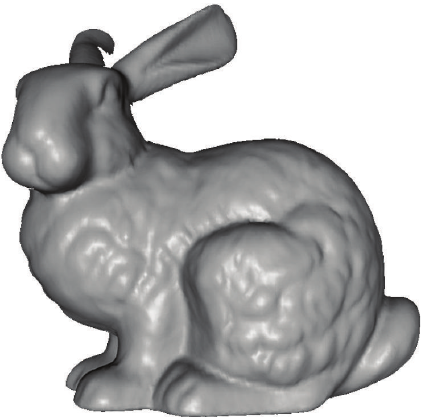
Figure 6: Bunny 3D mesh model.